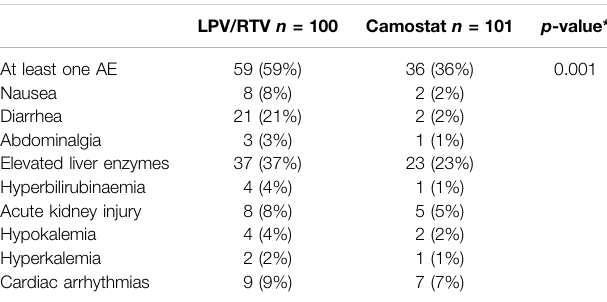
TABLE 3 | Adverse events